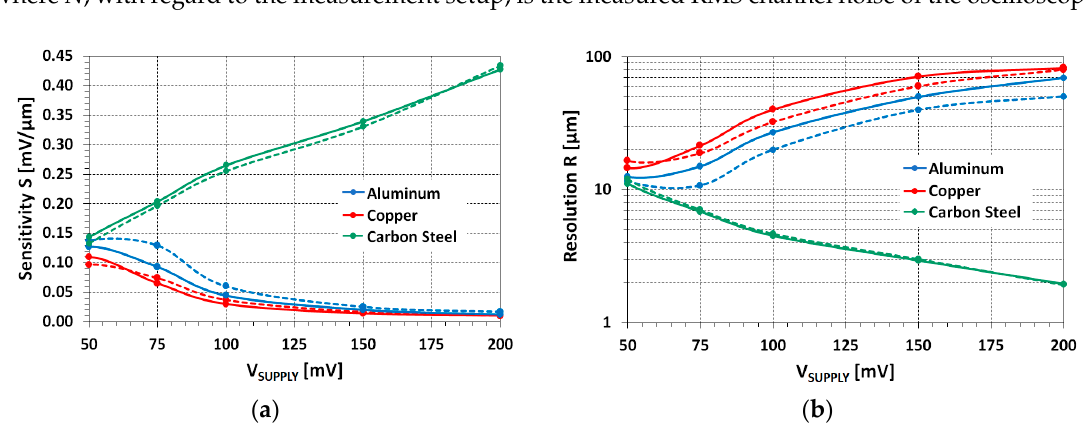
Figure 7. Comparison of the calculated sensitivity ( a ) and resolution ( b ) for different values of V SUPPLY , in the case of the sensing coil interacting with the considered 1 mm thick targets (solid lines) and 2 mm thick targets (dashed lines), respectively.